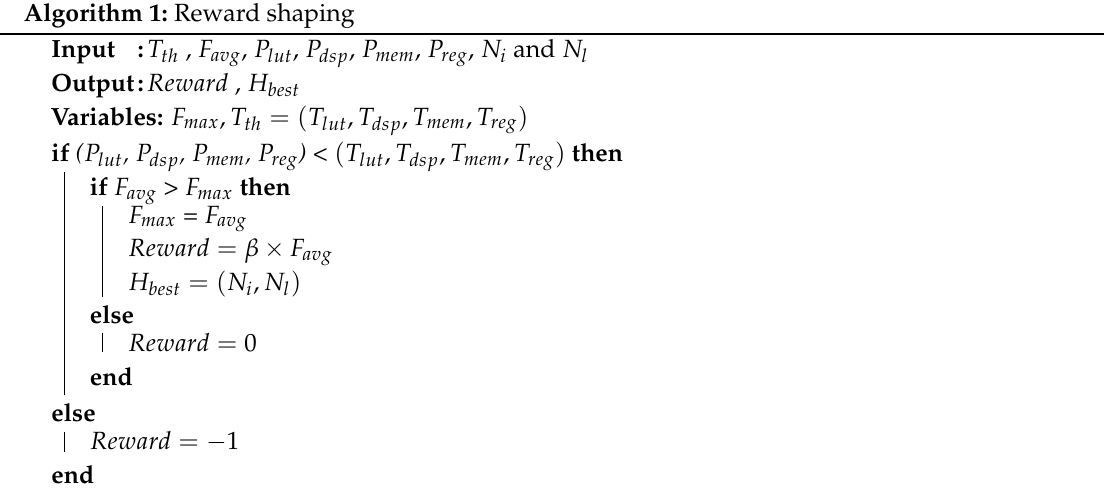
Algorithm 1: Reward